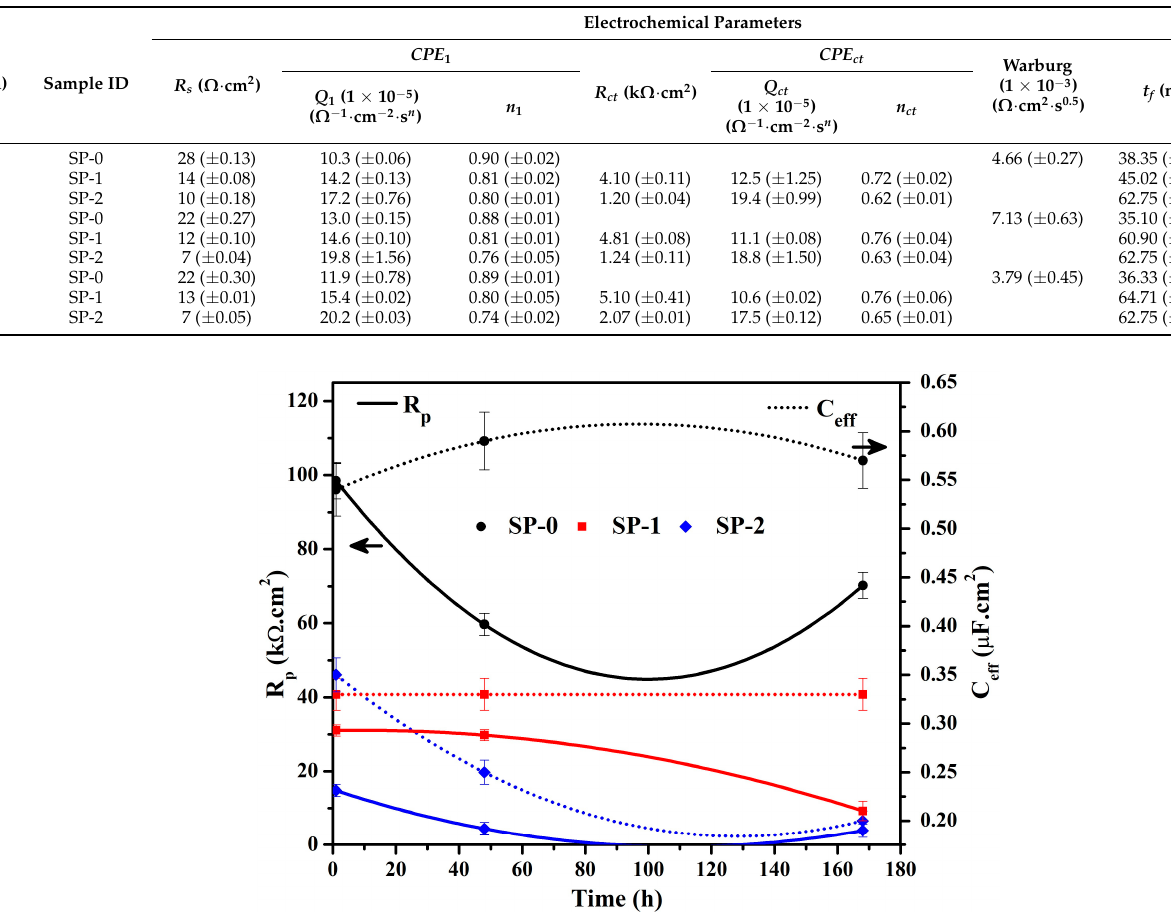
Table 3. Electrochemical parameters of steel rebar immersed in different solutions.